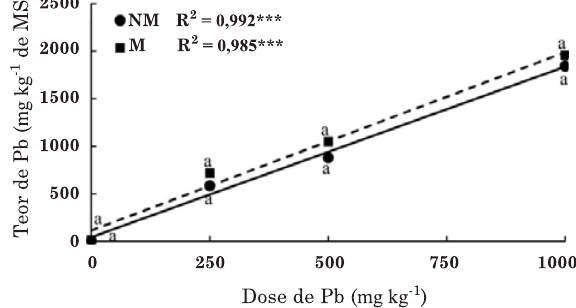
Figura 12. Teor de Pb em raízes de plantas de Stizolobium aterrimum micorrizadas (M – linha tracejada) e não micorrizadas (NM – linha